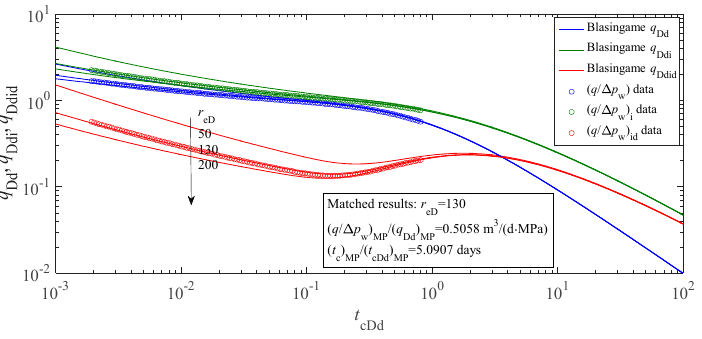
Figure 15. Match of production data for CRP case of q = 10 m 3 /d.